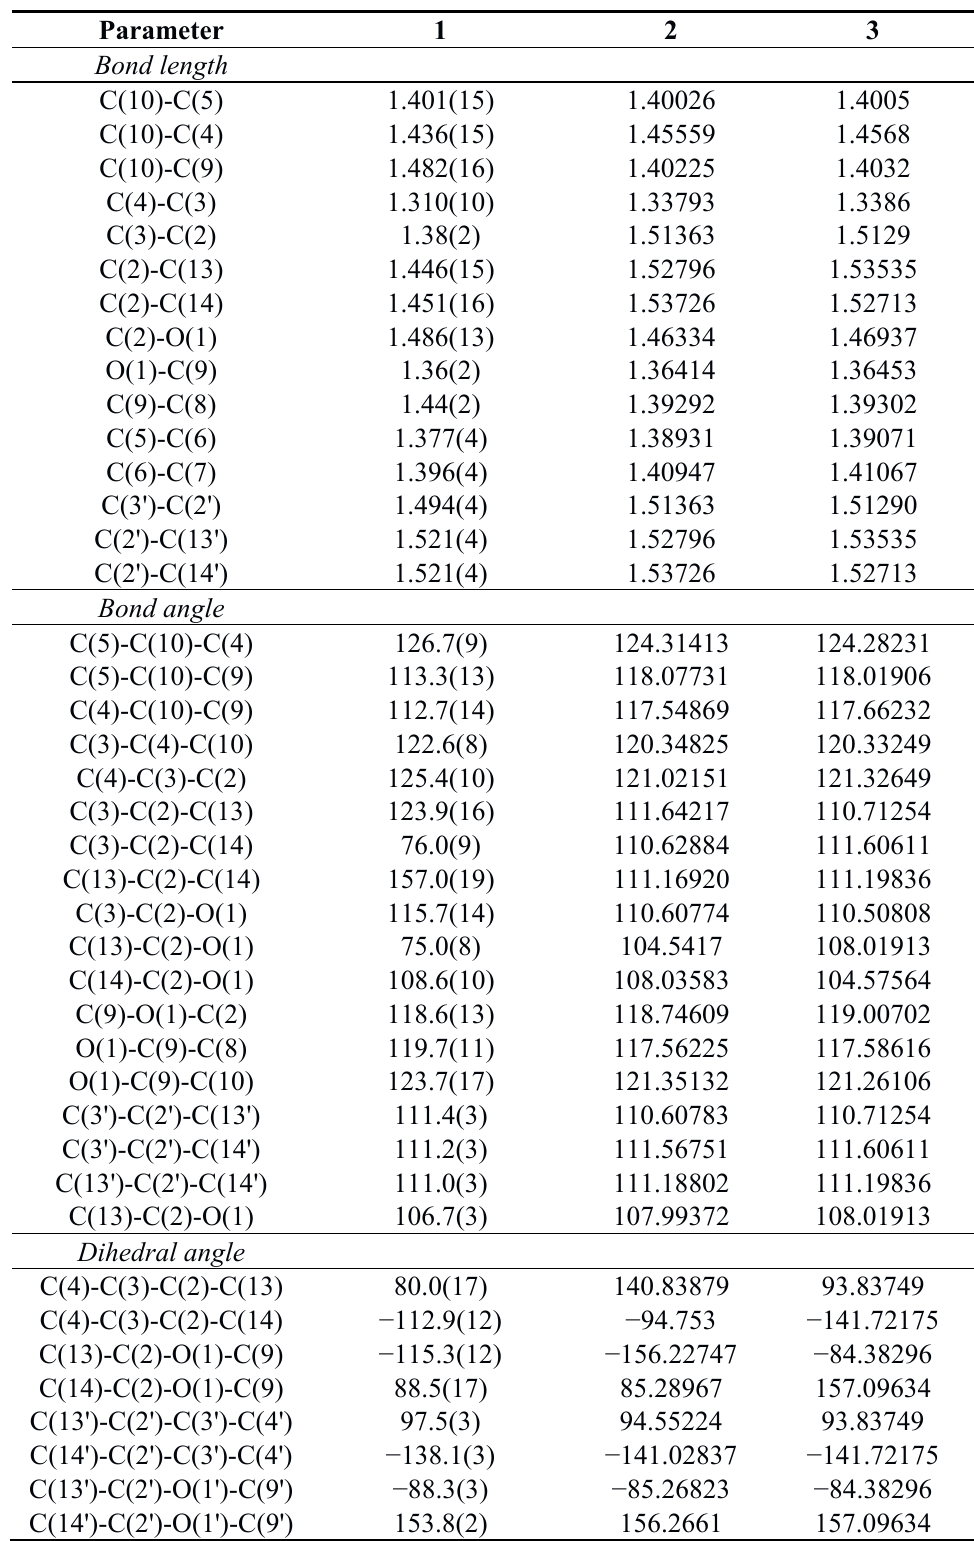
Table 2. Selected bond lengths (Å), bond angles and torsion angles (°) for ( − )-encecanescin ( 1 ) determined by X-ray diffraction and B3LYP calculations at the 6-311++G(d,p) level of